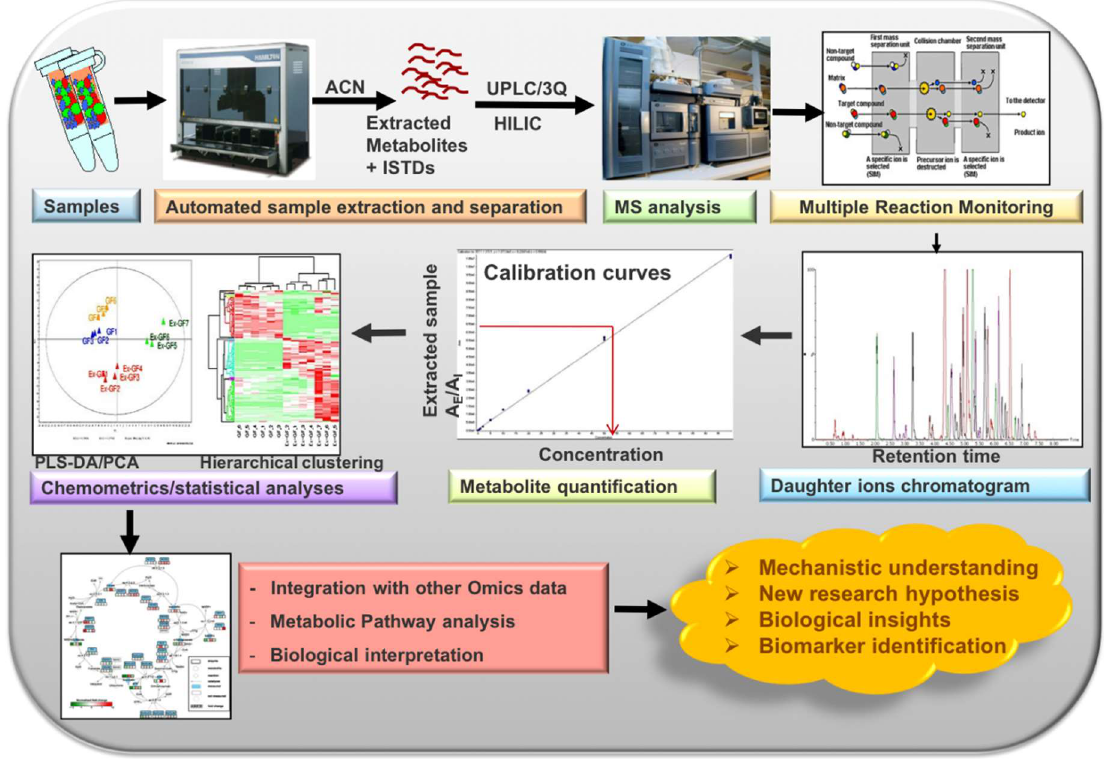
Figure 8. A typical workflow for high-throughput targeted metabolomics analysis.